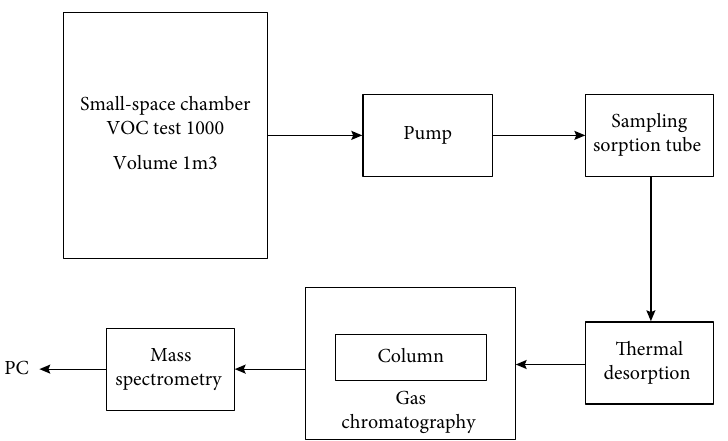
Figure 1: Flow chart of the various steps in VOC